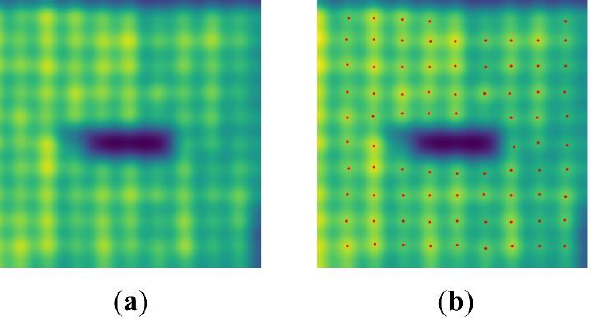
Figure 1. A feature map produced by CNN ( a ); extracted activation peaks ( b ).